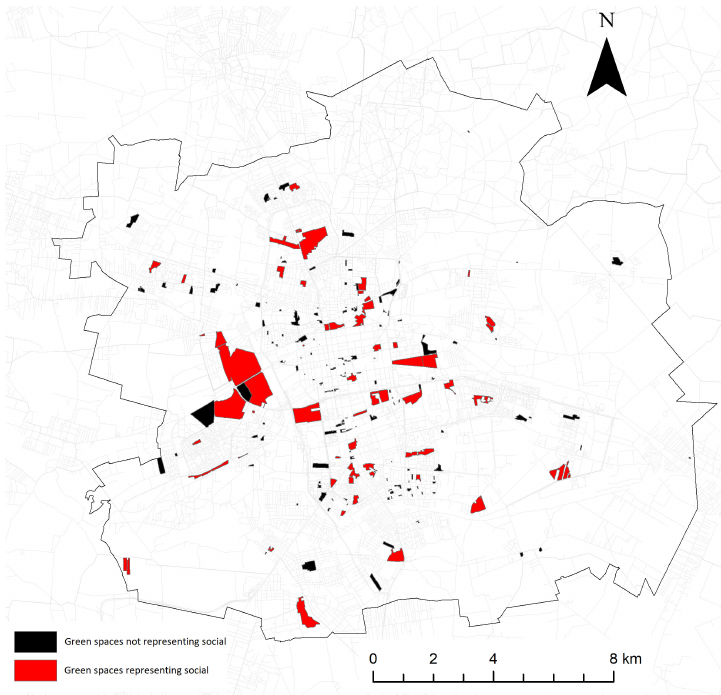
Figure 4. Urban green spaces in Lodz representing the “social” sociotope category.